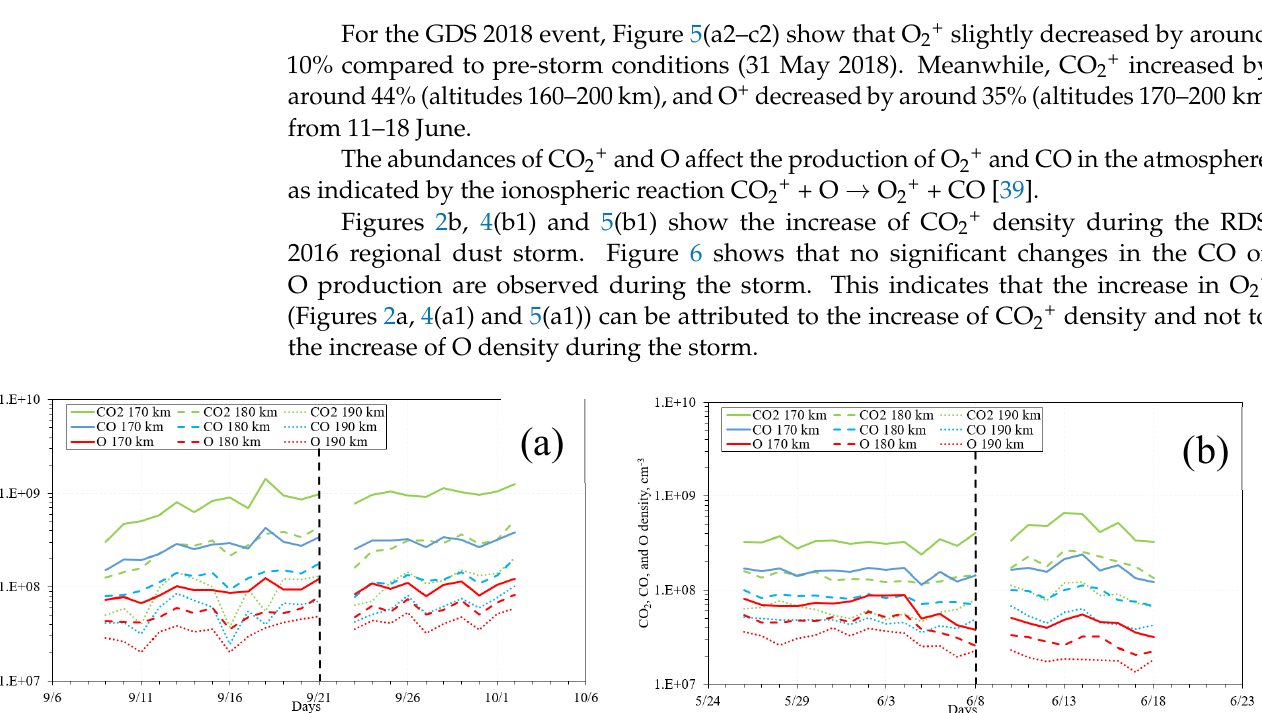
Figure 6. Density evolution of three neutral species, CO 2 (green lines), CO (blue lines), and O (red lines) from ( a ) 9 September to 4 October 2016, at altitudes of 160–240 km, ( b ) 27 May to 17 June 2018. The vertical black line indicates the storm onset. The blank regions represent missing NGIMS data.